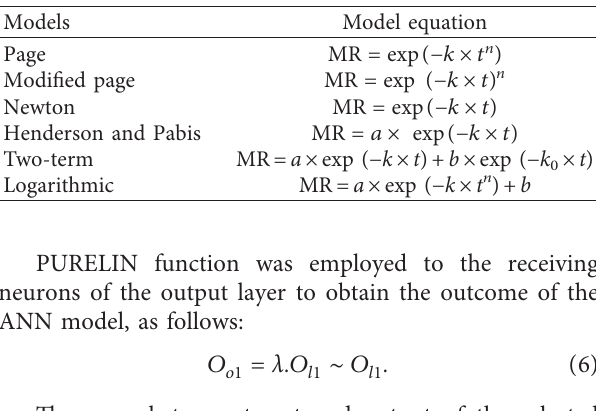
Table 3: Most commonly used semiempirical models for illus- trating the drying kinetics of